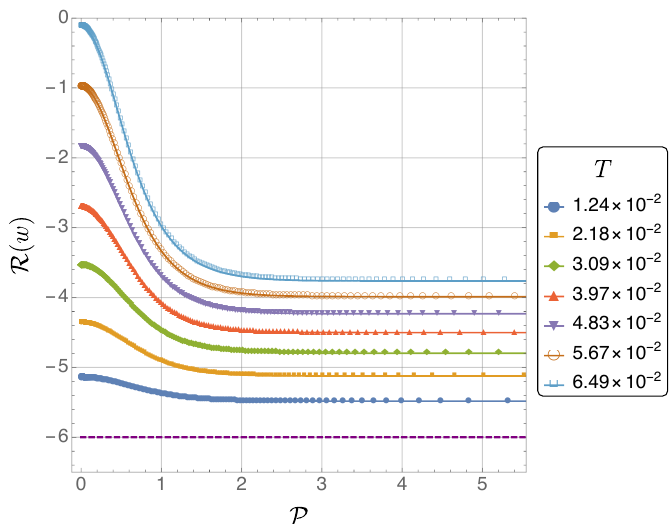
Figure 12 . Curvature of the induced horizon geometry as a function of the proper distance, along the horizon, from the axis of rotation. This plot was generated with (cid:22) = 3 and (cid:23) = 8 the range of temperatures is indicated in the legend above. The horizontal purple dashed curve indicates the curvature of an extremal uniform hyperbolic black hole.